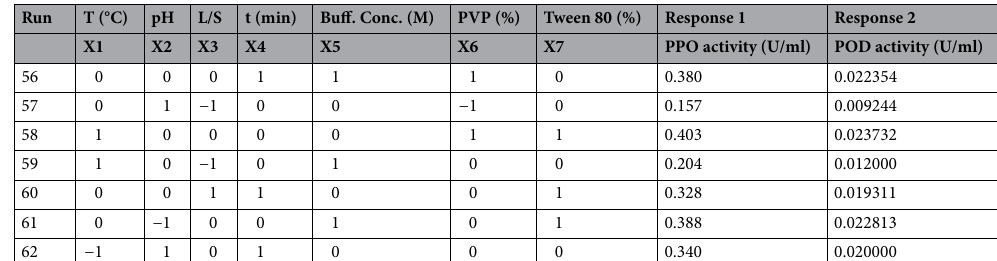
Run T (°C) pH L/S t (min) Buff. Conc. (M) PVP (%) Tween 80 (%) Response